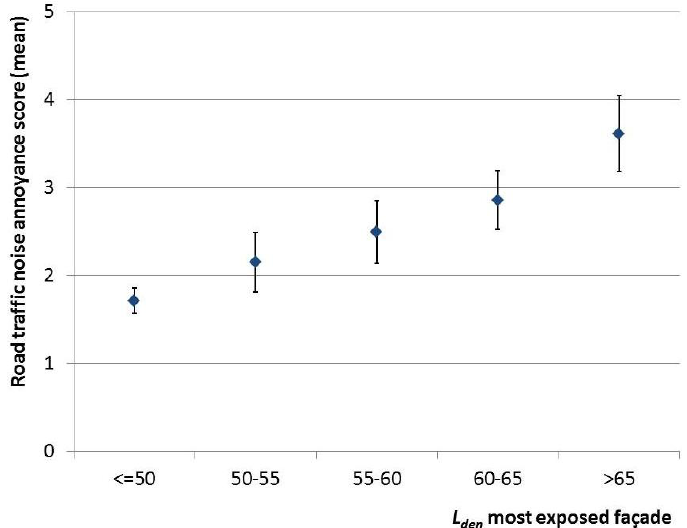
Figure 1. Mean road traffic noise annoyance score (scale 0 to 10), with 95% confidence intervals for the Amsterdam study